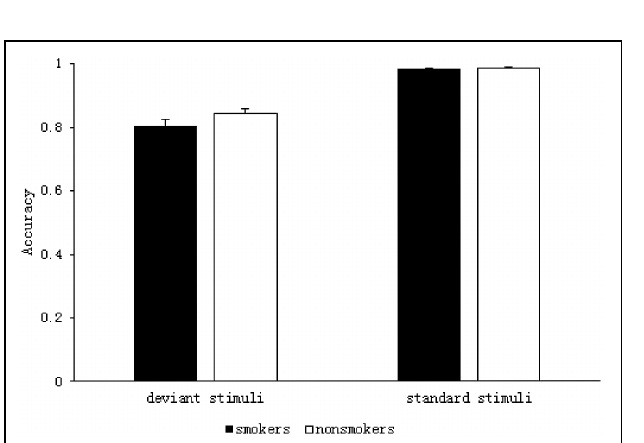
FIGURE 2 | Accuracy of smokers and non-smokers for standard and deviant stimuli.